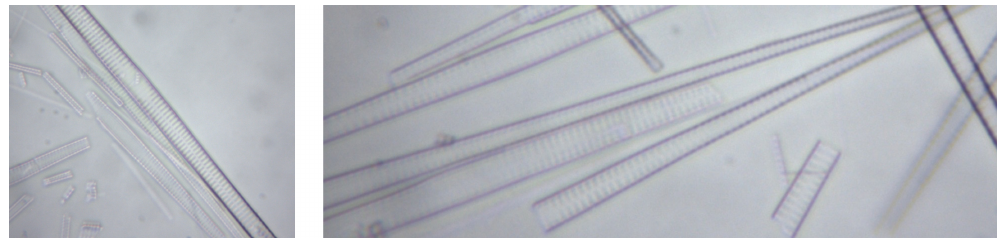
Figure 2. Light microscopy images of open trap diatom species from Lake Baikal ( × 1000). Images show the purity of samples used for δ 30 Si diatom analyses.